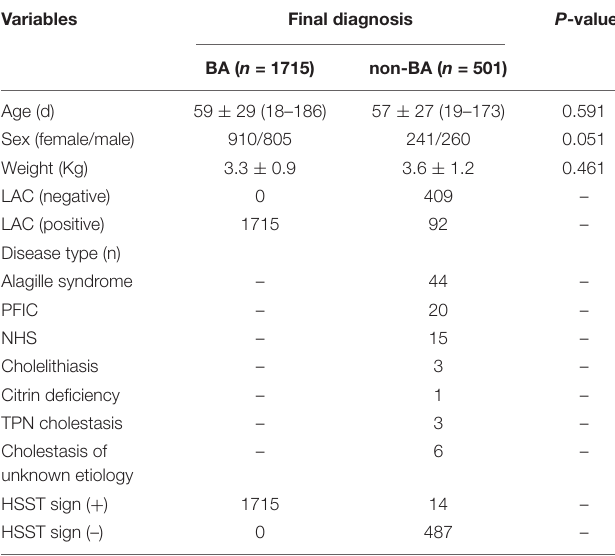
TABLE 1 | Clinical characteristics and demographics of the patients in the discovery cohort who underwent cholangiography.